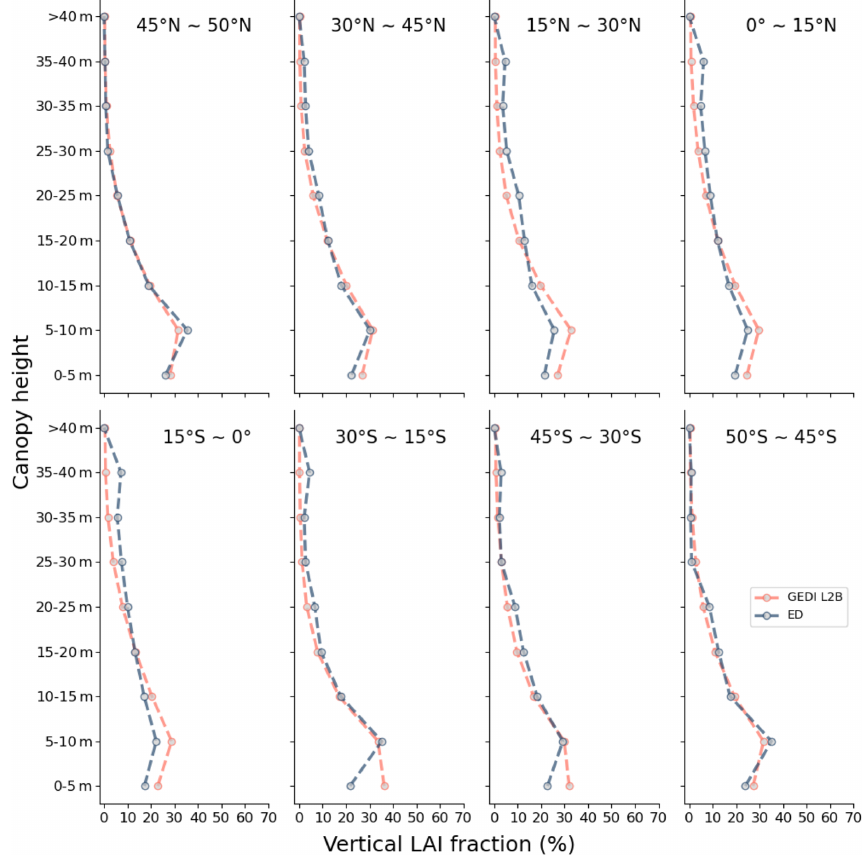
Figure 16. Relative fraction of vertical LAI by latitudinal band for ED and GEDI